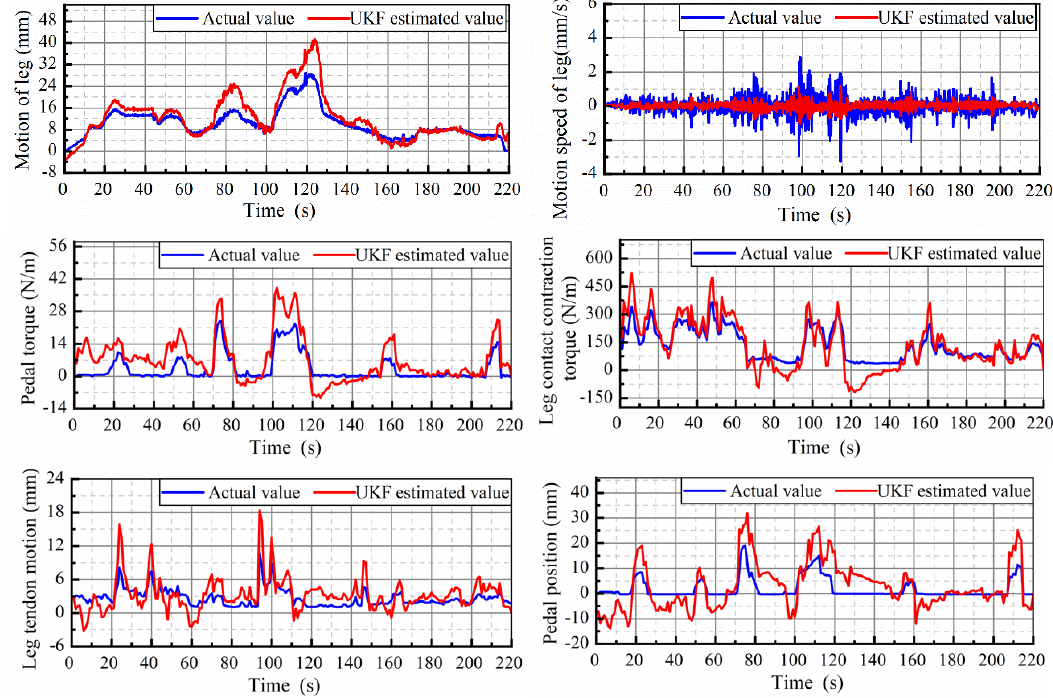
Figure 10. Arm state estimated value.